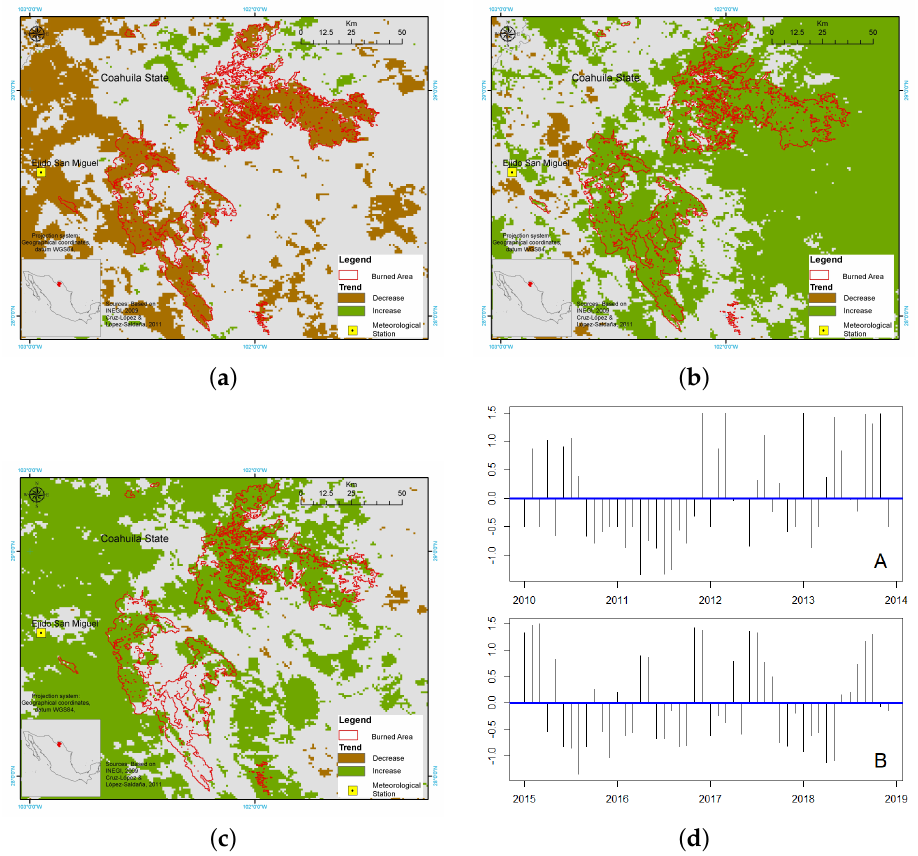
Figure 11. ( a – c ) Trend analysis describing the burned area and possible recovery at El Bonito and La Sabina in the Coahuila State. ( d ) Standard anomalies of precipitation at the meteorological station Ejido San Miguel: (A) 2010–2014; (B) 2015–2019. ( a ) EVI trend 2008–2011. ( b ) EVI trend 2011–2013. ( c ) EVI trend 2013–2020. ( d ) Precipitation standard anomalies at Ejido San